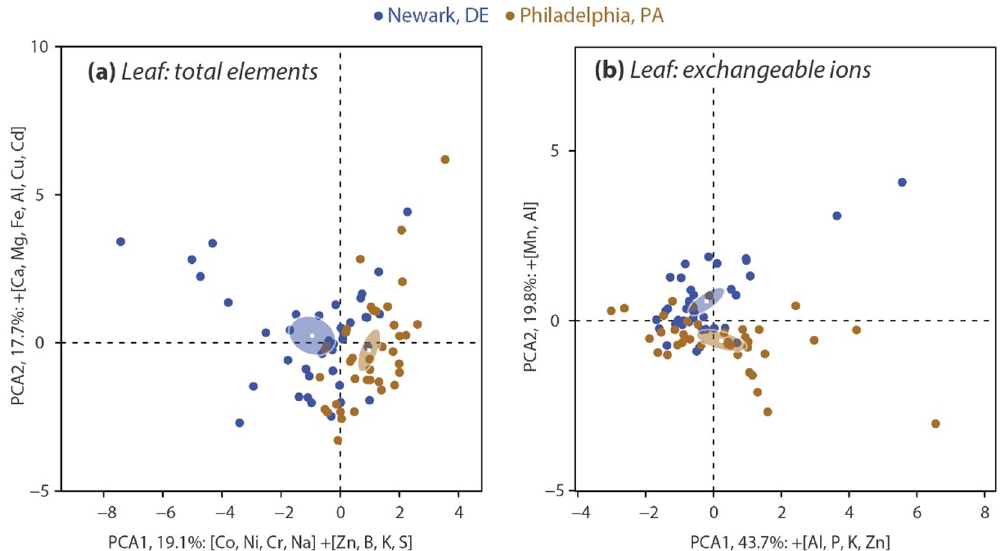
Fig 2. Principal component analysis of foliage of 77 mature native red maples for total (a) and exchangeable (b) elemental composition in ten urban deciduous forests in Newark, DE and Philadelphia, PA. Elements that most strongly loaded on each axis are listed next to their respective axis in order of strongest to weakest. (+) represents values that are positive and strongly loaded on the axis; (-) represents values that are negative and strongly correlated to the axis. The ellipses represent the group mean for each